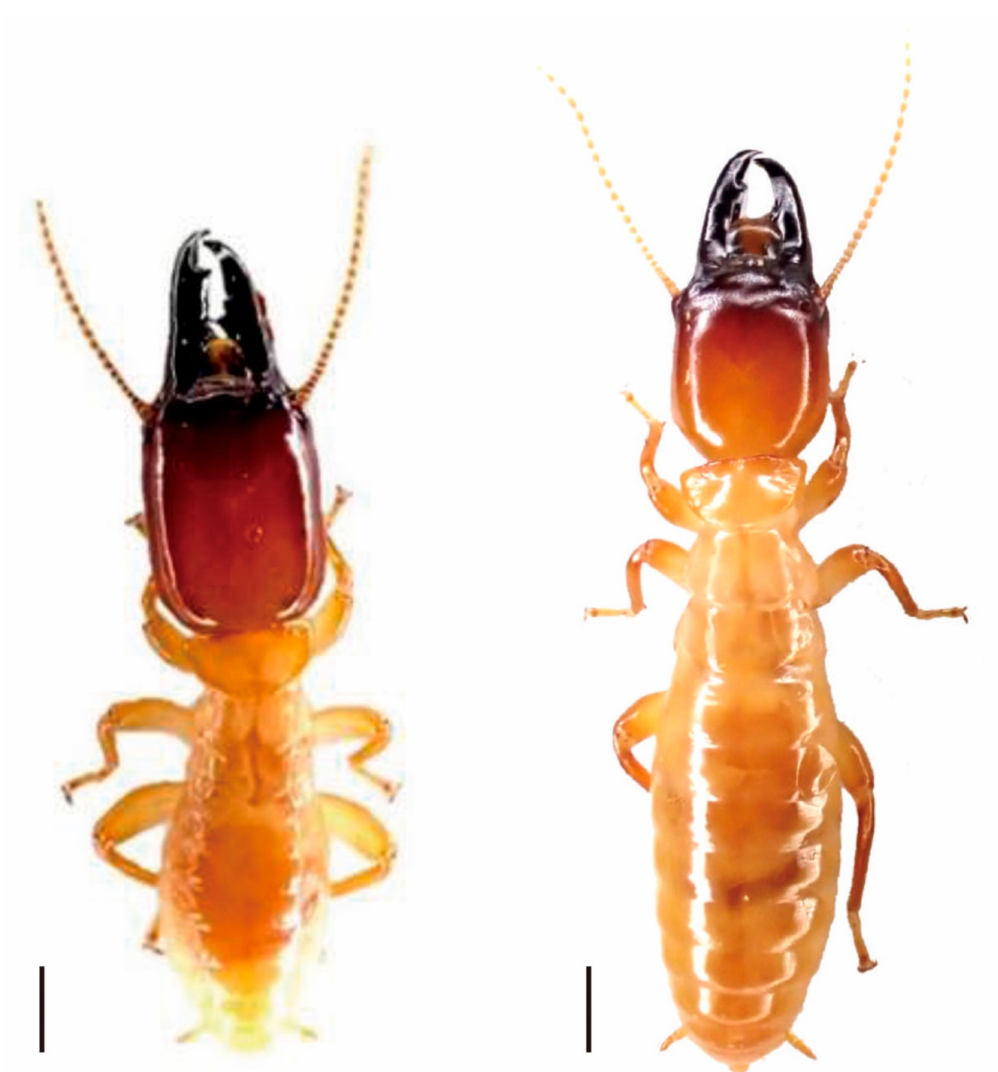
Figure 1. Male phenotypes of the normal soldier ( left ) and reproductive soldier ( right ) observed in an incipient colony of Z. nevadensis . Reproductive soldiers possess rounded heads, smaller mandibles, and larger abdomens than did normal soldiers. Scale bar indicates 1